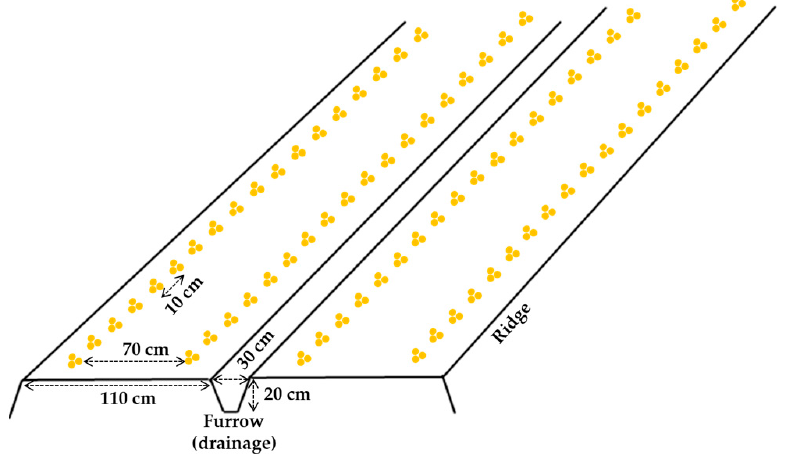
Figure 1. Schematic drawing of the ridges for sowing with a density of 70 cm (row space) × 10 cm (hill space) and furrow for the drainage.